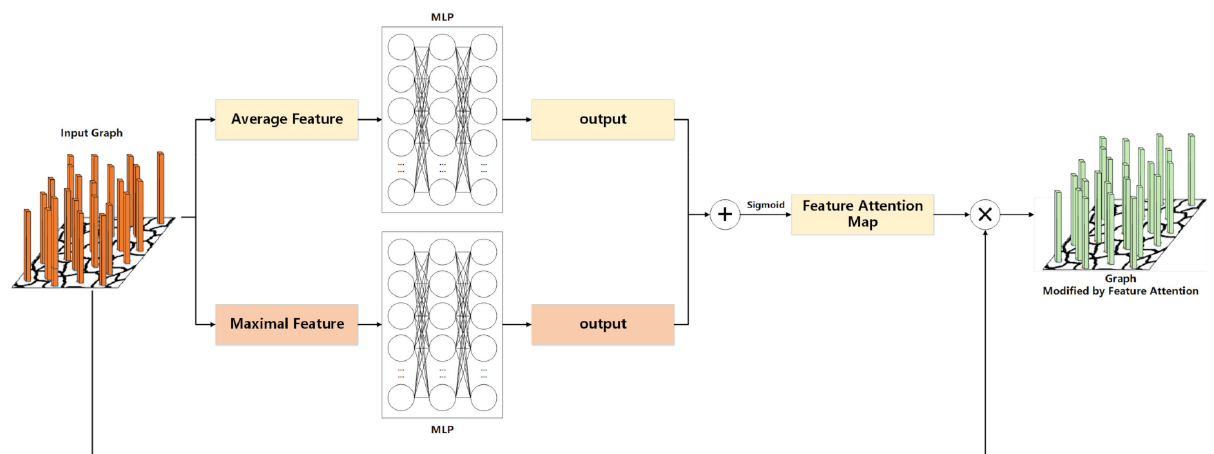
Figure 5. The overview of feature attention